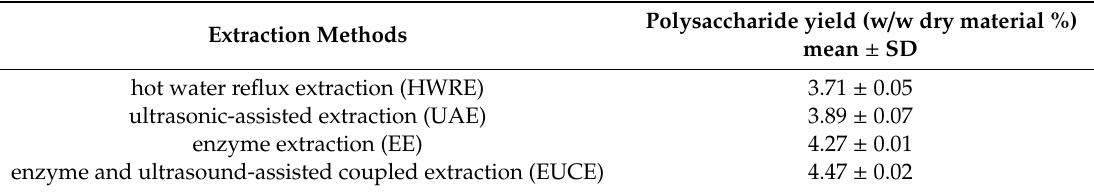
Table 1. Comparison of extraction methods of polysaccharides from Taxus cuspidata branches and leaves (TCBL).